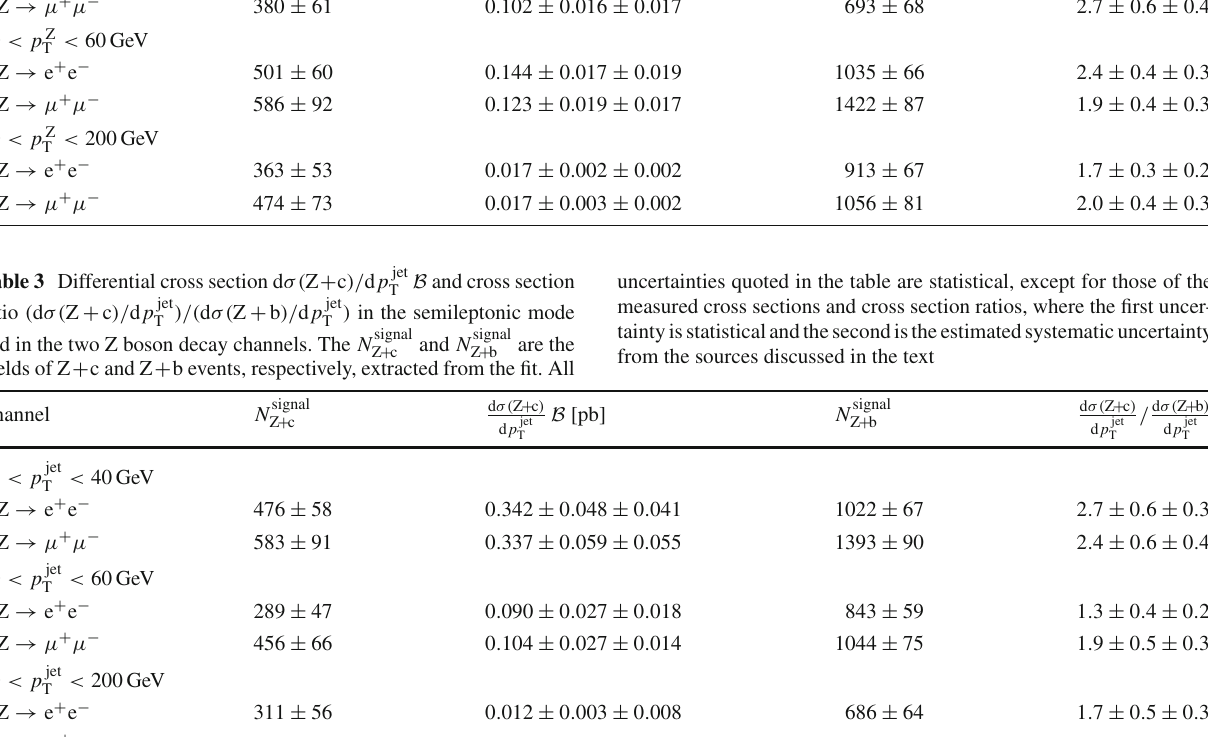
with heavy flavour content) are given in the upper (lower) part of the table. The first uncertainty is statistical and the second is the systematic uncertainty arising from the sources discussed in the